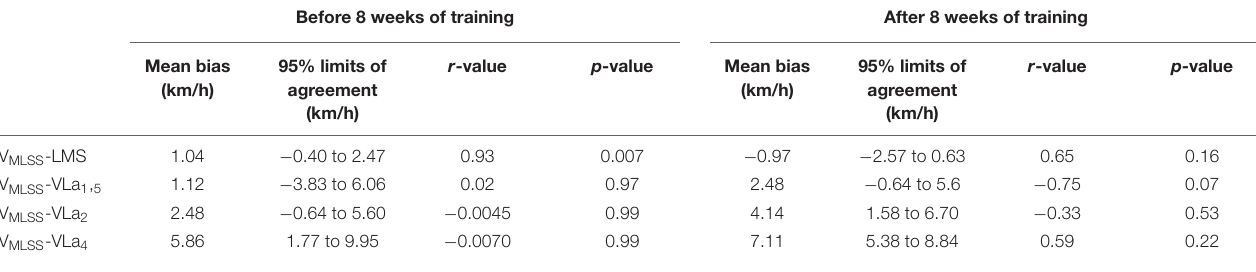
TABLE 4 | The mean bias and the 95% limits of agreement for the Bland-Altman method and the Pearson’s correlation coefficient ( r - and p -value) between the V MLSS and the LMS/VLa 1 . 5 , 2 , 4 before and after 8 weeks of